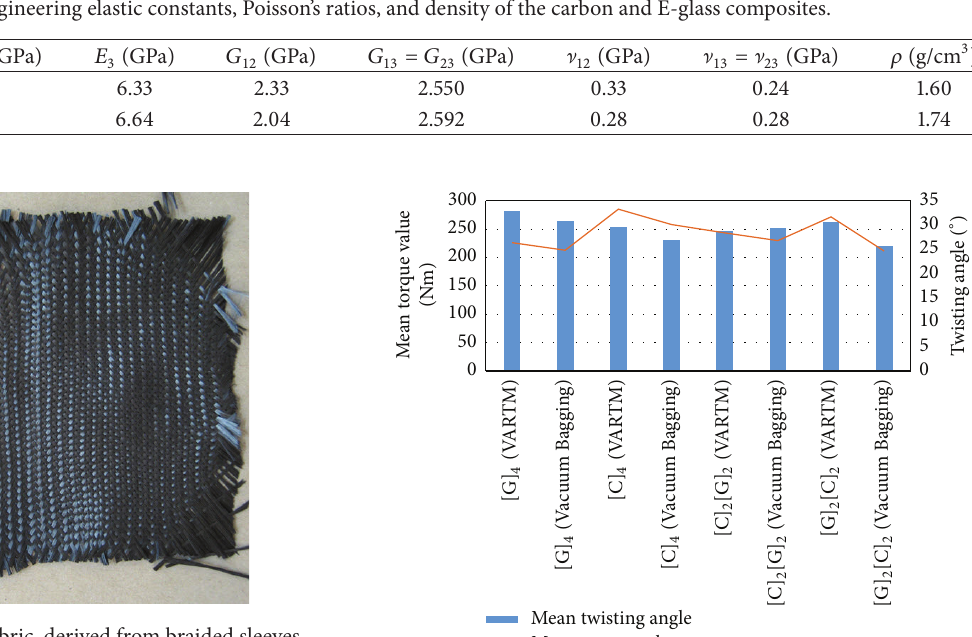
Figure 9: Carbon fiber fabric, derived from braided sleeves.